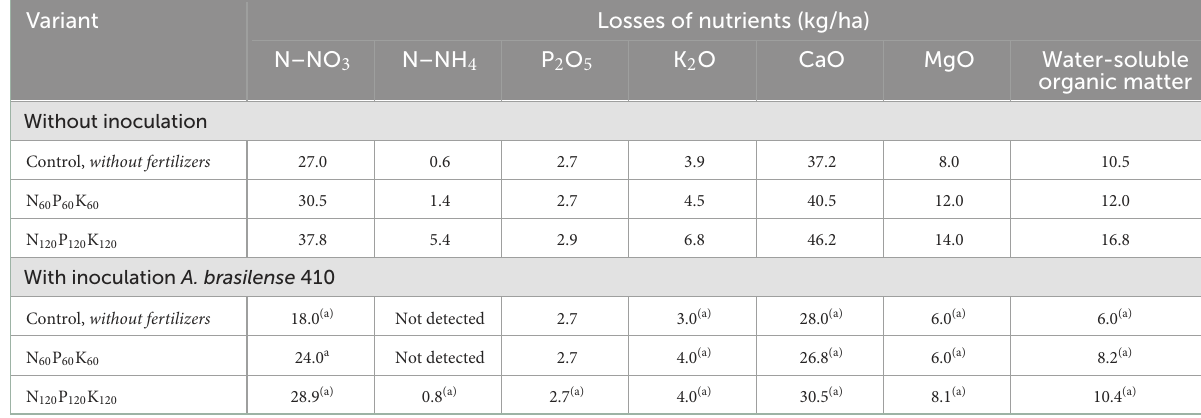
TABLE 1 The effect of fertilizers and pre-sowing spring barley seeds inoculation with A. brasilense 410 on losses of nutrients and water-soluble organic matter with drainage waters (April–August 2016) . Variant